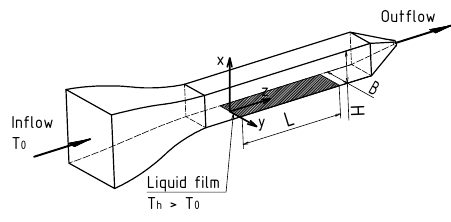
Fig. 1. Schematic of the channel with used coordinate